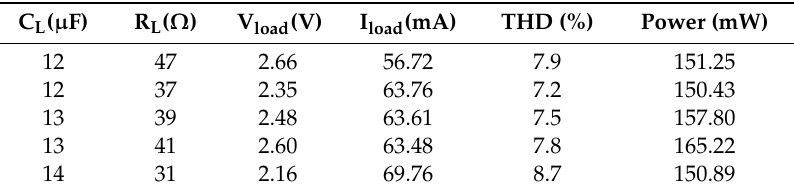
Table 2. Harvester configurations for specific requirements.